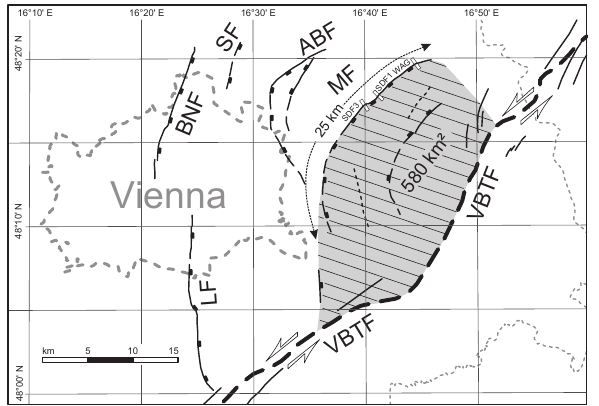
Figure 14. Geometry and fault area of the Markgrafneusiedl Fault (MF). Also shown are the Vienna Basin Transfer Fault (VBTF) and other active normal splay faults branching from the VBTF. ABF: Aderklaa–Bockfliess fault system; BNF: Bisamberg– Nussdorf fault; LF: Leopoldsdorf fault; SF: Seyring fault (redrawn from Decker et al., 2015). Broken grey line marks the city limits of